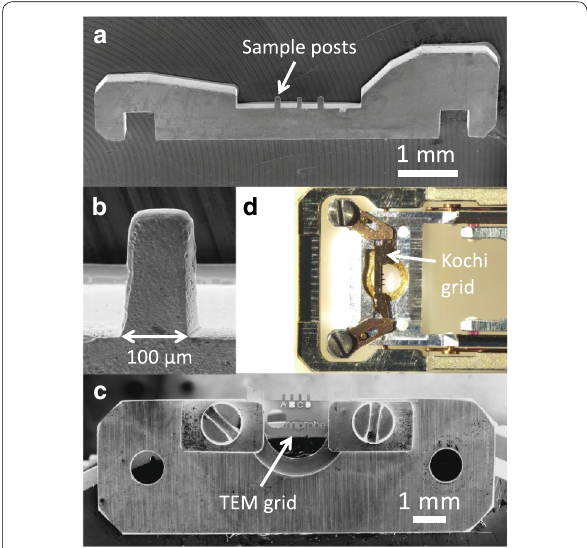
Fig. 2 Pictures of a the Kochi grid, b a sample post of the Kochi grid, c the Kochi grid in a JEOL-type transmission electron microscopy (TEM) sample holder, and d the Kochi clamp with a commercial TEM grid